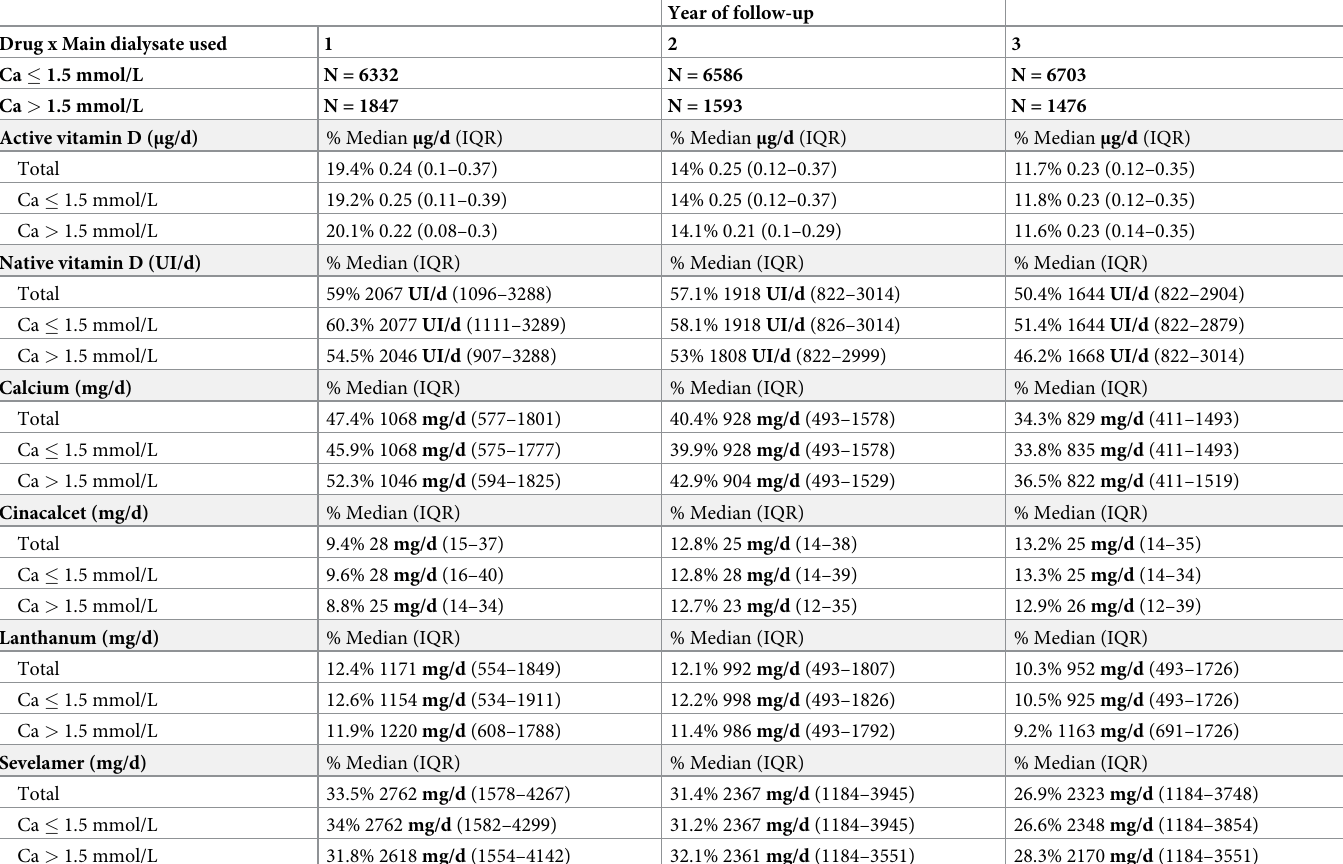
Table 5. Medications prescriptions as a function of the main facility-level dialysate calcium concentration, for the 8179 patients with at least 3 years of follow-up and having been identified in the French national health